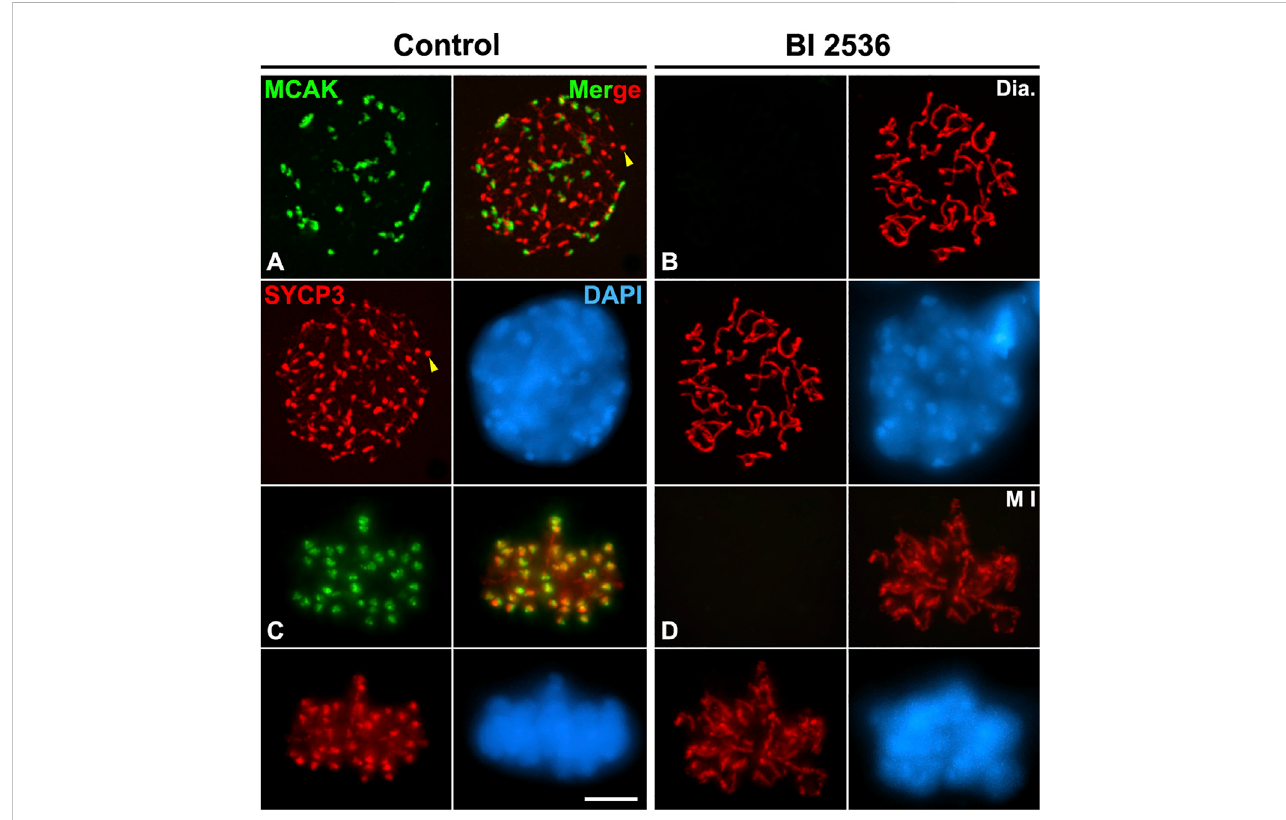
PLK1 regulates the SGO2-dependent loading of MCAK to the inner centromeres. Double immunolabeling of MCAK (green) and SYCP3 (red), and counterstaining of the chromatin with DAPI (blue) on squashed diakinesis (Dia.) (A) and metaphase I (M I) (C) control spermatocytes, and diakinesis (B) and metaphase I (D) BI 2536-treated spermatocytes. Yellow arrowheads indicate SYCP3 agglomerates inthenucleoplasm ofthecontrol diakinesis spermatocyte. Scale bar represents 5 μ